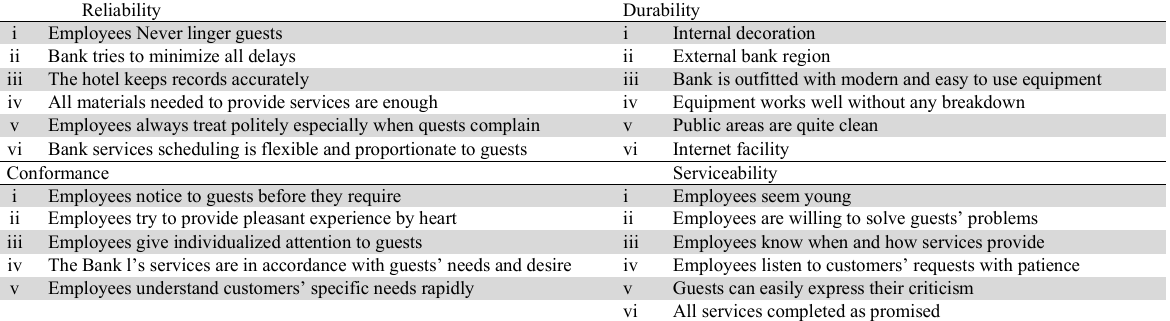
Variables used to measure service